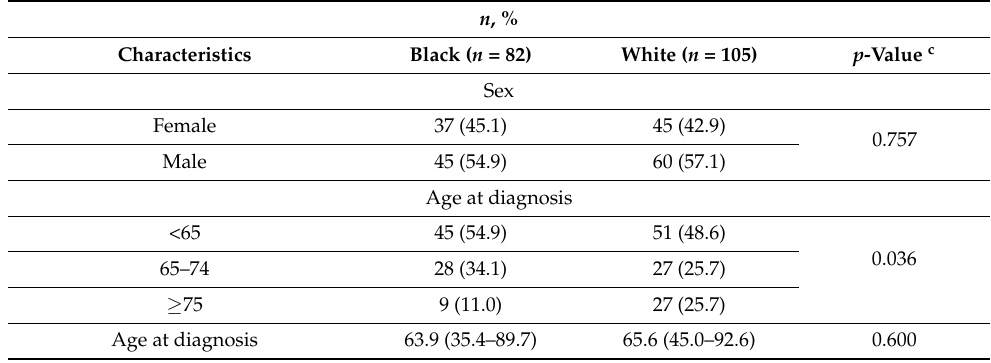
Table 2. Qualitative and Quantitative Characteristics by Race in Stage IV NSCLC patients ( n = 187) a,b . n ,